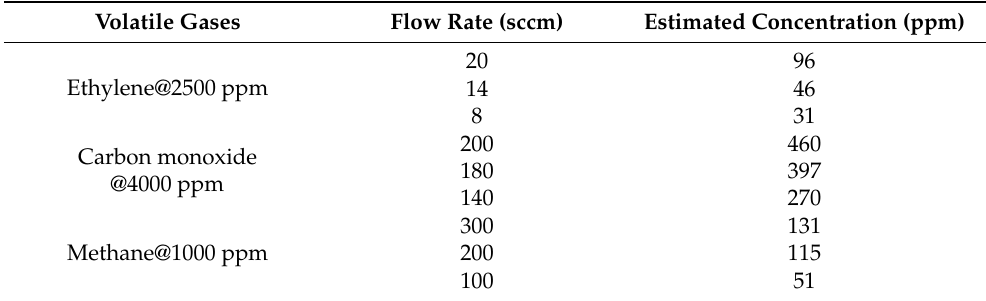
Table 2. Average estimated concentrations of the three gases at different flow rates obtained by gas chromatography-mass spectrometry.